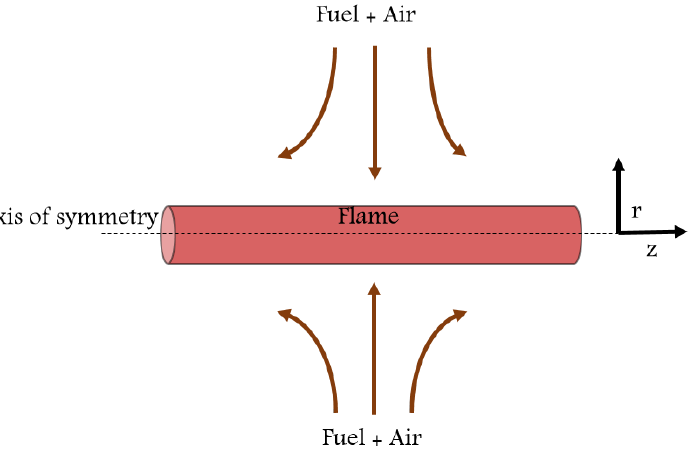
Figure 6. An illustration of tubular premixed flame configuration.